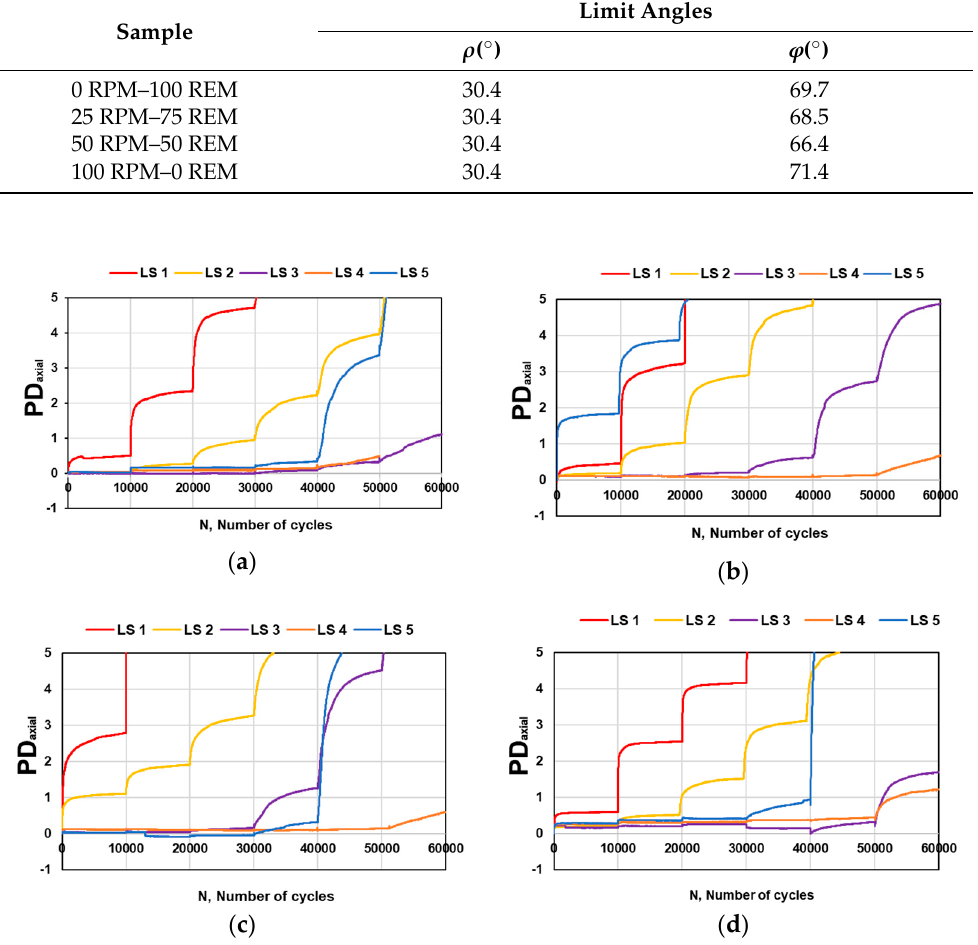
Figure 9. Permanent deformation (PD) of REM and RPM as function of the load cycles (N) for ( a ) 0% RPM–100% REM; ( b ) 25% RPM–75% REM; ( c ) 50% RPM–50% REM, and ( d ) 100% RPM–0% REM.